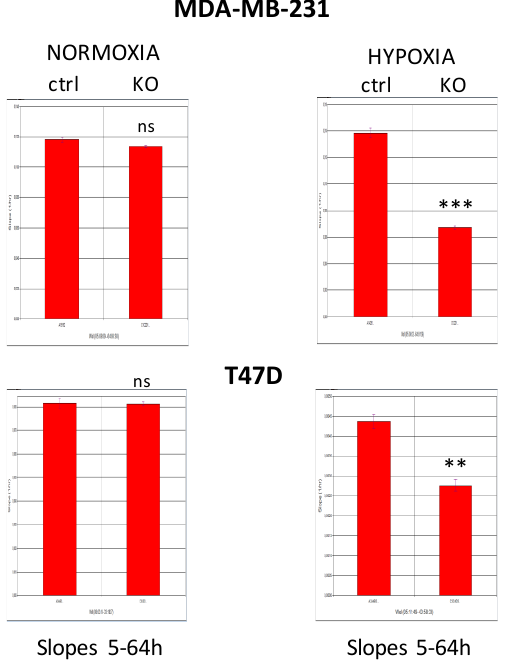
Figure 4. The effect of CAIX knockdown on cell proliferation. MDA-MB-231 and T47D mock cells (ctrl) and their CAIX KO counterparts were cultured in normoxic or hypoxic (1% O2) conditions. Proliferation was monitored in real-time using the xCELLigence system and expressed as the cell index. Slopes derived from the measurement data indicate the rate of cell growth between time points 5–64 h. The experiment was repeated two times in quadruplicates. p > 0.05 was considered nonsignificant (ns), p < 0.05 is denoted as *, p < 0.01 as ** and p < 0.001 as ***.